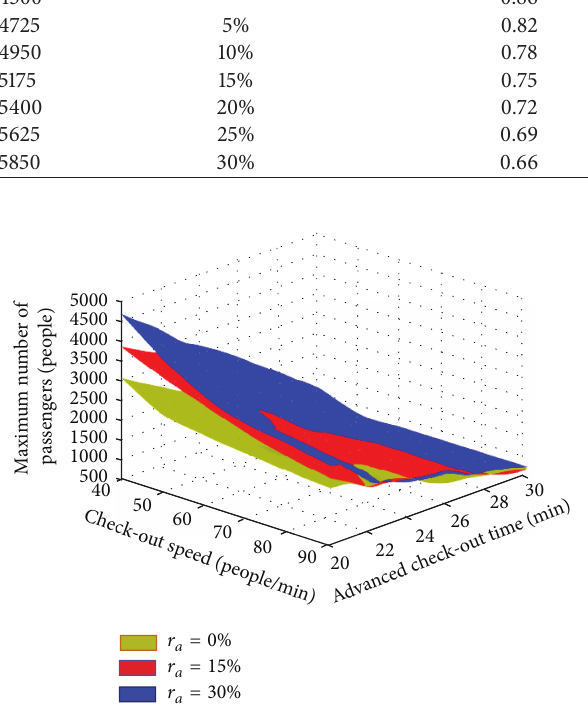
Figure 10: The maximum number of passengers in waiting room varies over the values of 𝑡 𝑐 and V 𝑐